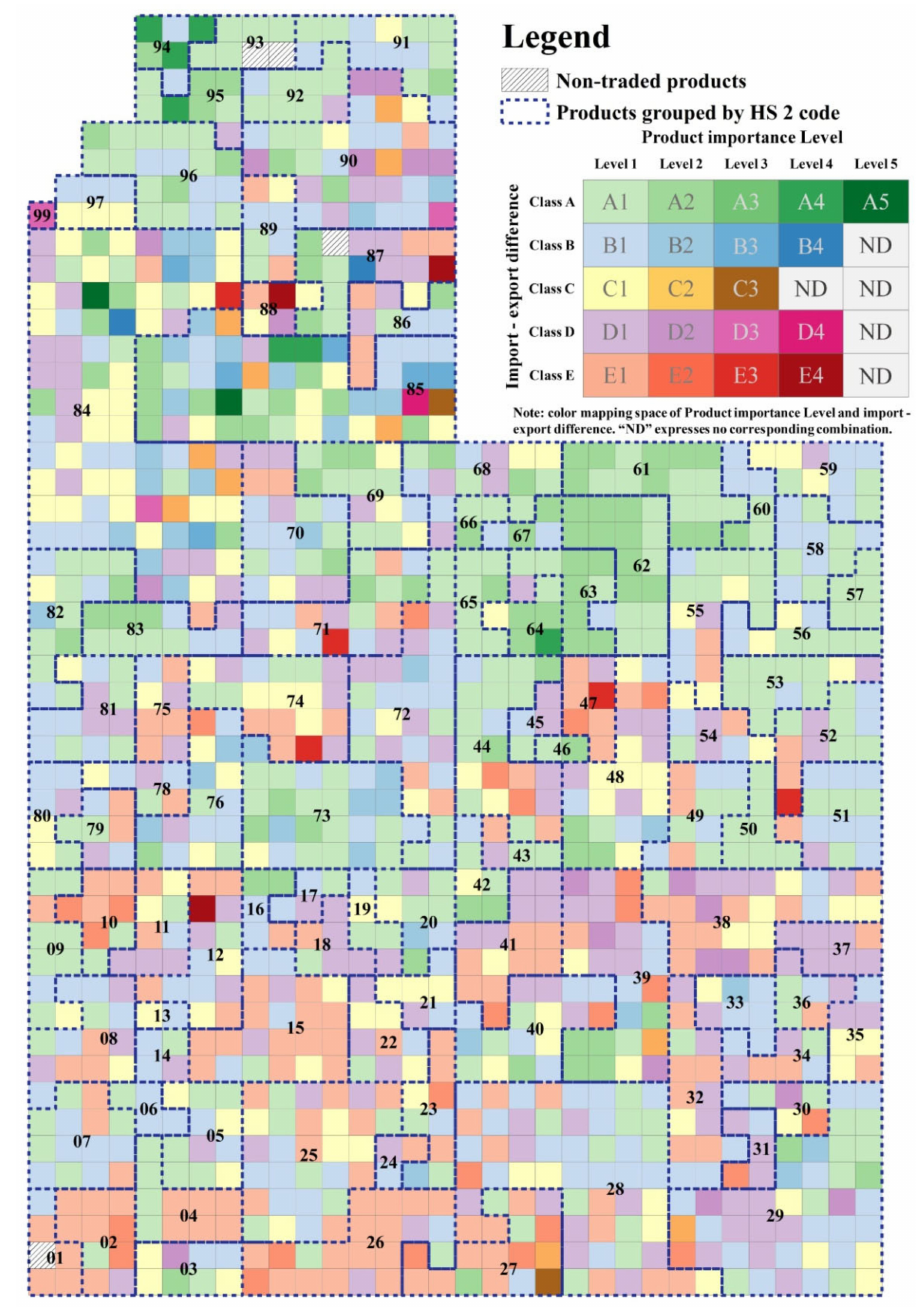
Figure A4. Detailed information for spatial pattern of products import–export di ff erence